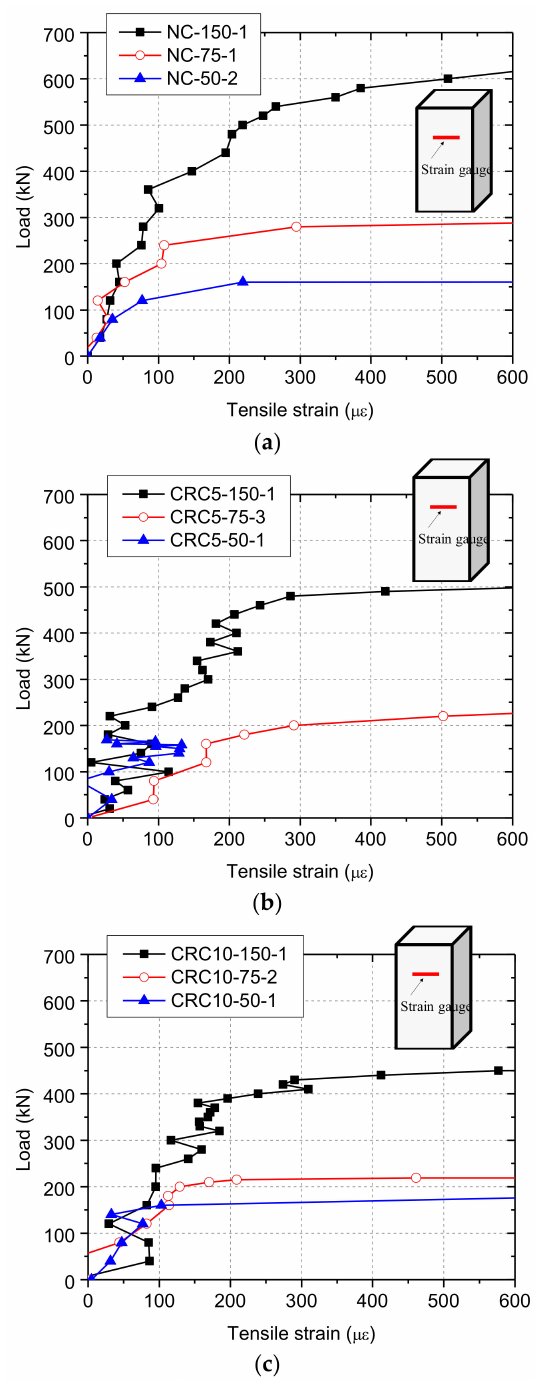
Figure 12. Results of tensile strain: ( a ) NC; ( b ) CRC5; ( c )